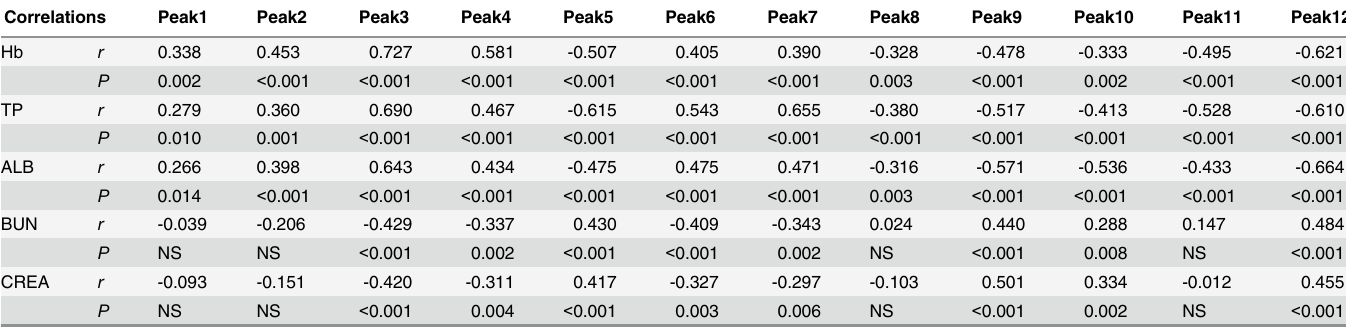
DSA-FACE (Fig 4C and 4G). The abundance of LCA-binding proteins in severe group was sig- nificantly lower than that in control group ( P = 0.002) (Fig 4D). Moreover, the abundance of PHA-E-binding proteins in moderate and severe groups were obviously decreased than those